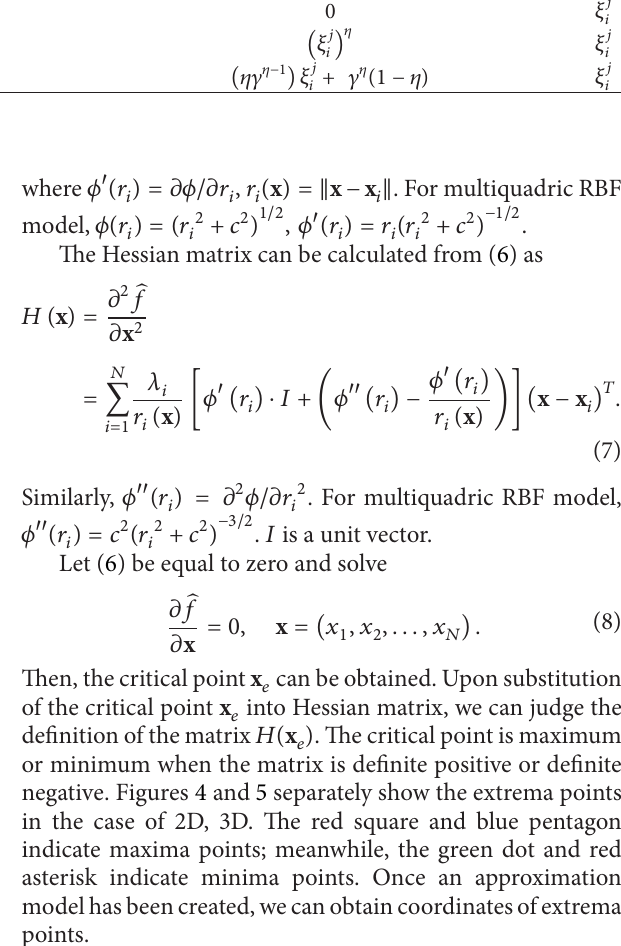
Table 2: Nonradial basis functions 𝜓(𝜉